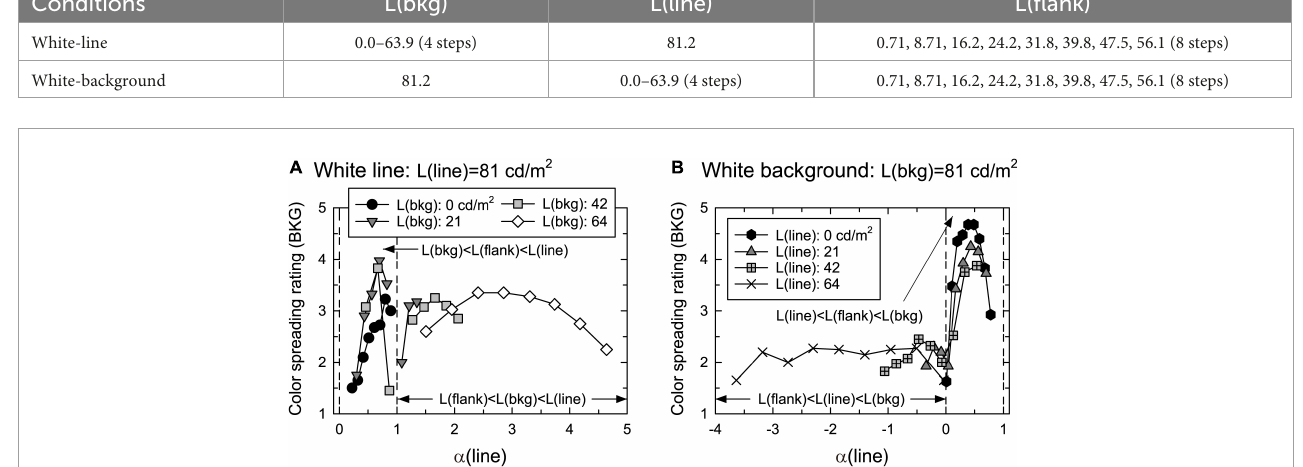
FIGURE5 Mean confidence ratings of color spreading over the background as a function of α (line) in (A) white-line and (B) white-background conditions. Other aspects are the same as those in Figure 4 .